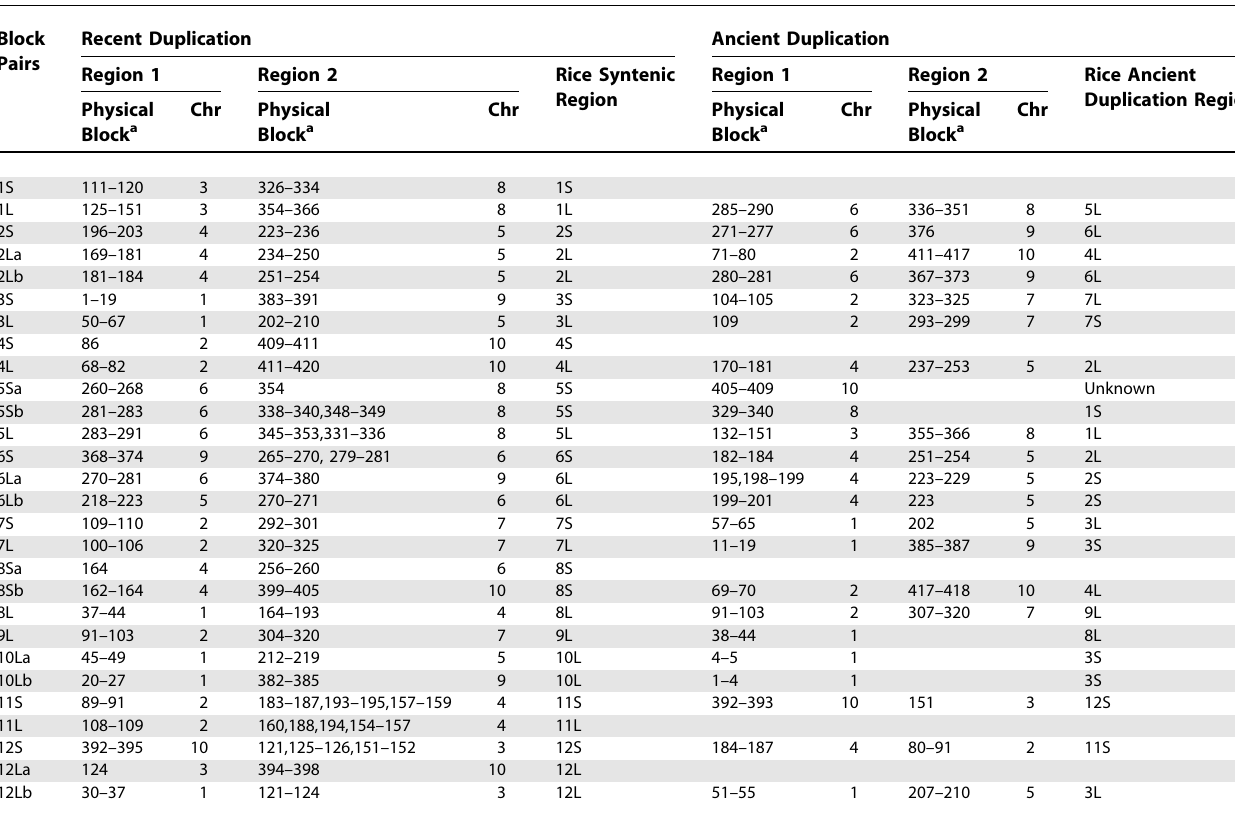
Table 3. Two Genome Duplication Events in Maize Genome Evolution Block Recent Pairs